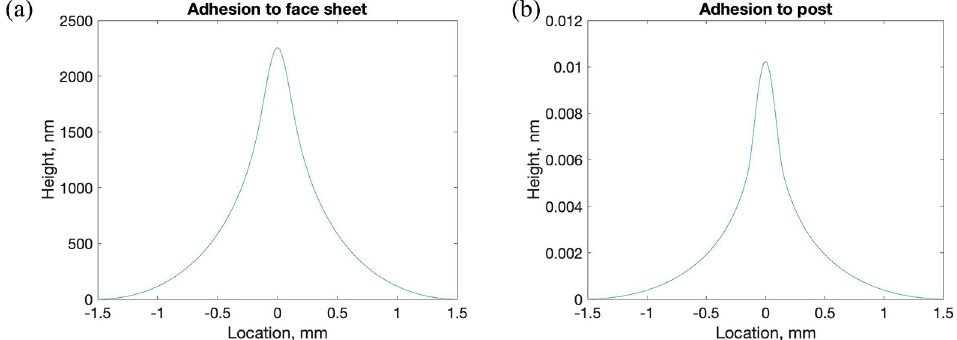
Figure 3. Simulation results for the new design approach, illustrating a substantial reduction in face sheet deformation due to adhesive stresses based on the location of the adhesive connection. ( a ) Simulated surface profile across the idealized single-actuator silicon DM face sheet (3 mm diameter, 10 µm thickness) with a stressed (5 MPa) adhesive joint (300 µm diameter, 5 µm thickness) directly connected to the bottom of the face sheet. Peak deformation was 2.2 µ m, and deviation from flatness was 626 nm-rms. ( b ) Simulated topography of the same face sheet with the same adhesive joint connected to an integral silicon post (diameter 300 µ m, height 500 µ m) extending from the bottom of the face sheet. Peak simulated face sheet deformation was 0.01 nm, and deviation from flatness was 0.002 nm-rms.